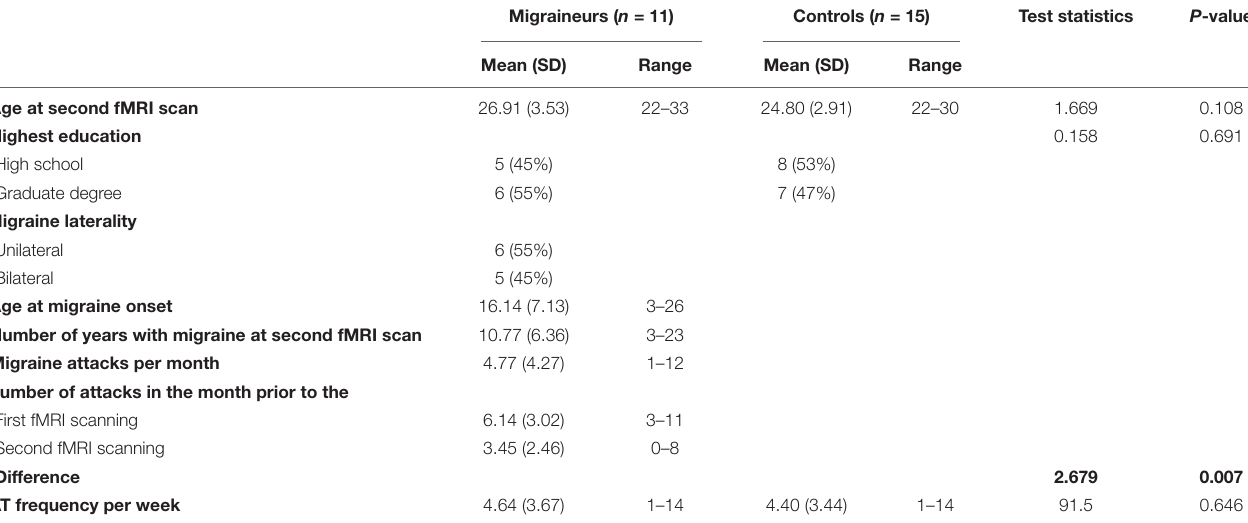
TABLE 1 | Demographic and clinical characteristics of migraineurs and healthy